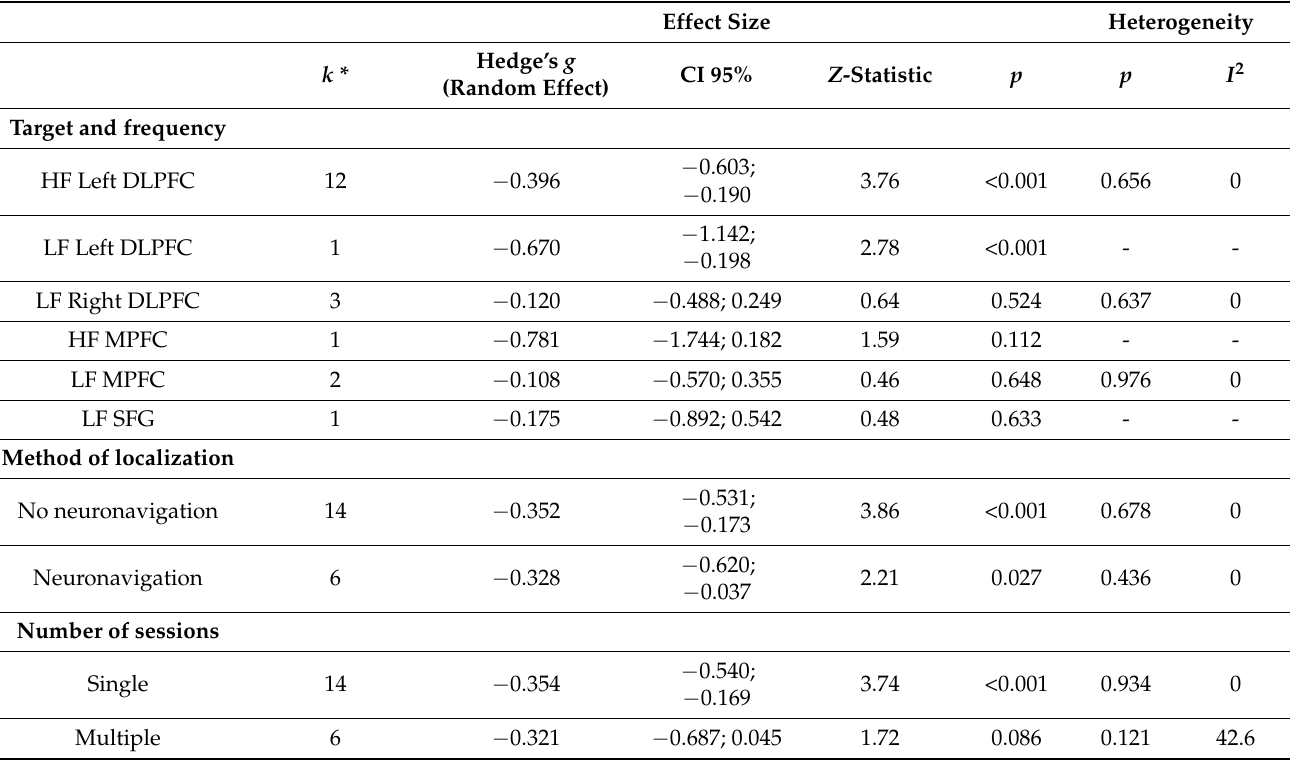
Table 1. Subgroup analysis on stimulation settings (target and frequency, method of localization, number of sessions (single versus multiple)) for stimulant (nicotine, cocaine, methamphetamine) and behavioral (eating disorder, gambling disorder) groups ( k =